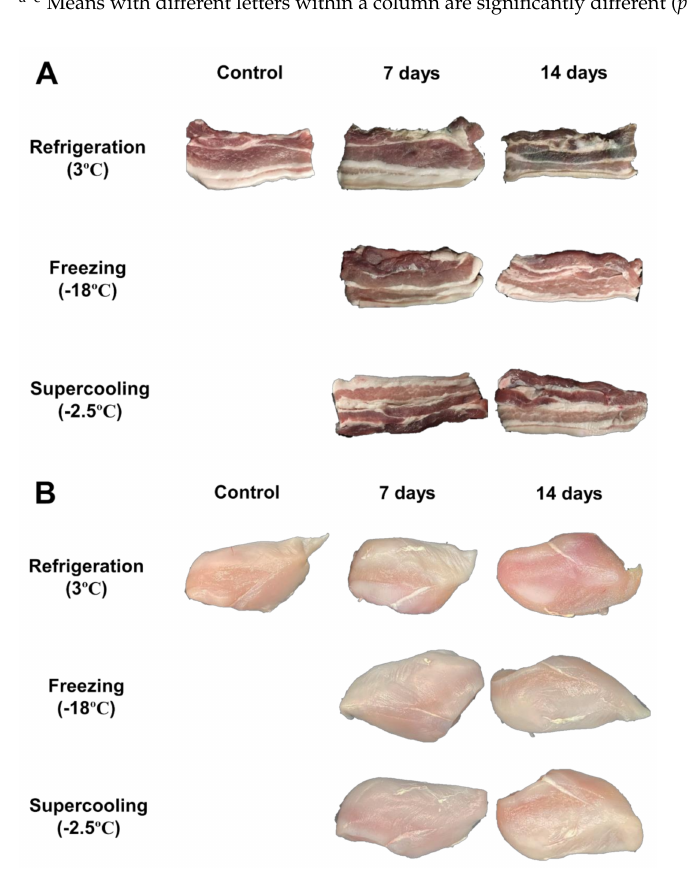
Figure 4. Changes in appearance of pork belly and chicken breast depending on various storage temperatures and